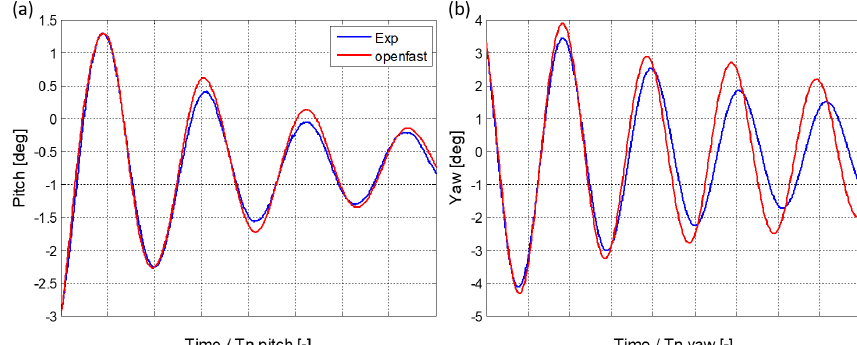
Figure 5. Free-decay results for (a) pitch and (b) yaw.